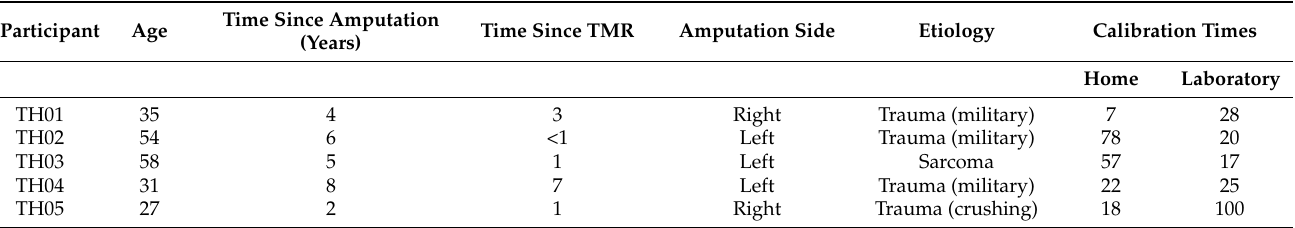
Table 1. Participants enrolled in the dataset